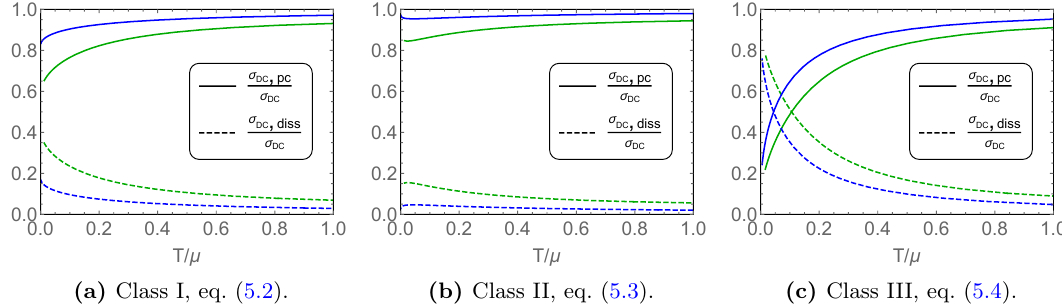
Figure 5. The relative contributions of two terms to the conductivity in (5.1). The green and blue curves represent k=(cid:22) = (5 ; 10)